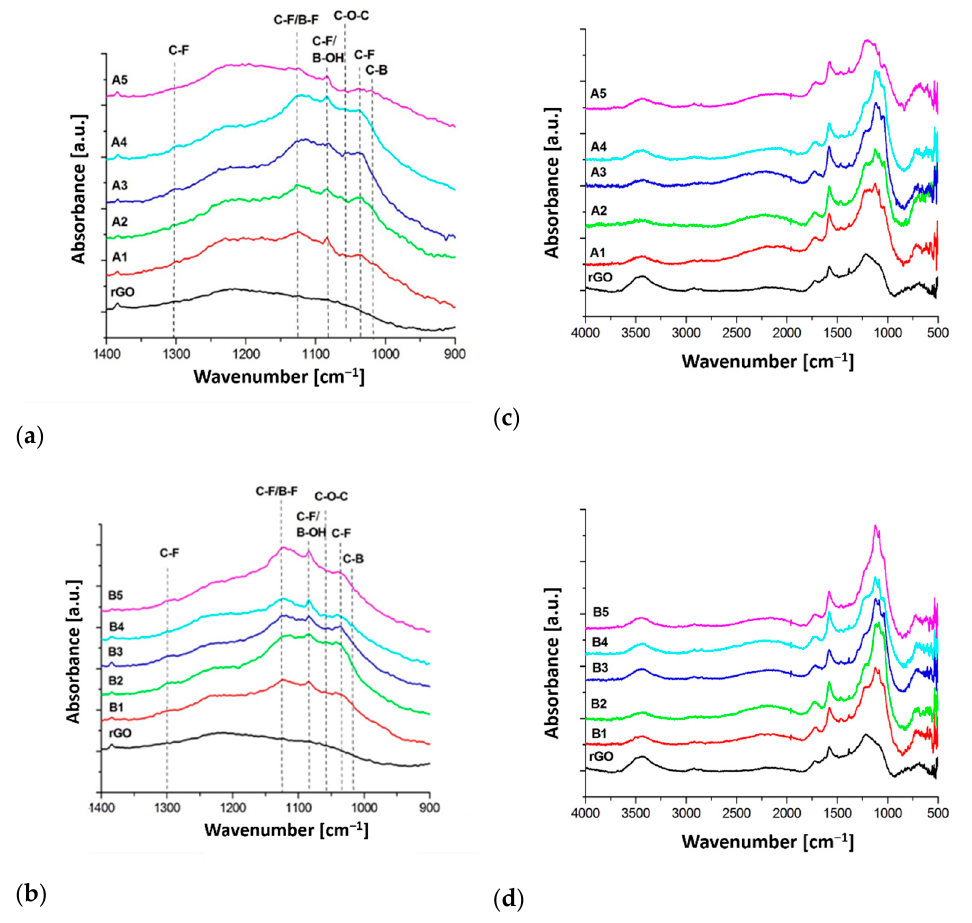
Figure 4. FTIR spectra of rGO without modification and functionalization with BF 3 ·THF at 1.5% concentration (samples A1–A5) ( a ) and 3% concentration (samples B1–B5) ( b ) with relevant wavenumbers highlighted, and the full analyzed spectra for both cases ( c ) for samples A1–A5, ( d ) for samples B1–B5.